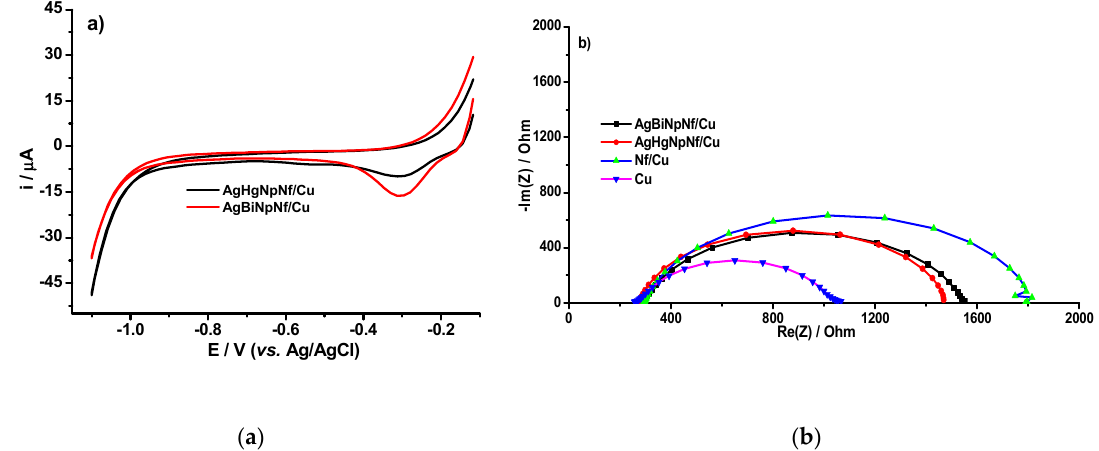
Figure 3. ( a ) Cyclic voltammetry (CV) responses of the AgHgNf/Cu and AgBiNf/Cu electrodes in a 0.1 mol L − 1 ammonium chloride buffer solution, pH 9.5. Scan rate 0.01 V s − 1 . ( b ) Nyquist impedance of the Cu electrode (purple curve), Nf/Cu electrode (blue curve), AgHgNf/Cu electrode (red curve), and AgBiNf/Cu electrode (black curve) in a 0.1 mol L − 1 ammonium chloride buffer solution, pH 9.5, at − 1.1 V. The frequency range is from 0.1 Hz. to 100 kHz.